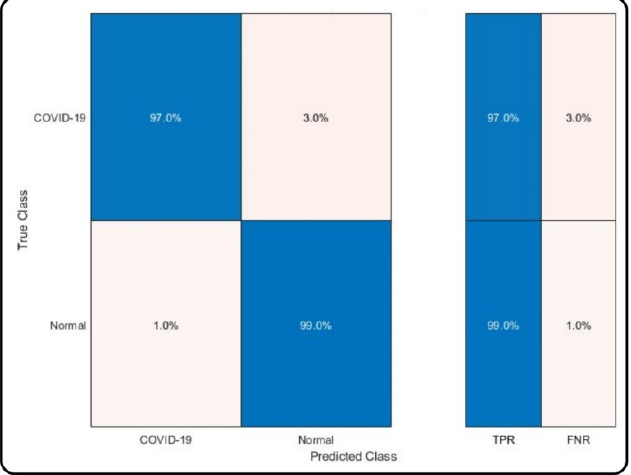
Figure 7. Confusion matrix of the MC-SVM classifier using the proposed technique.